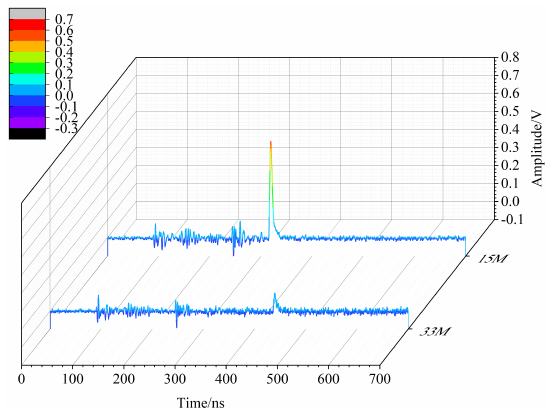
Figure 4. Echoes of the standard diffuse reflector with a bidirectional reflectivity factor (BRF) of 50% at different